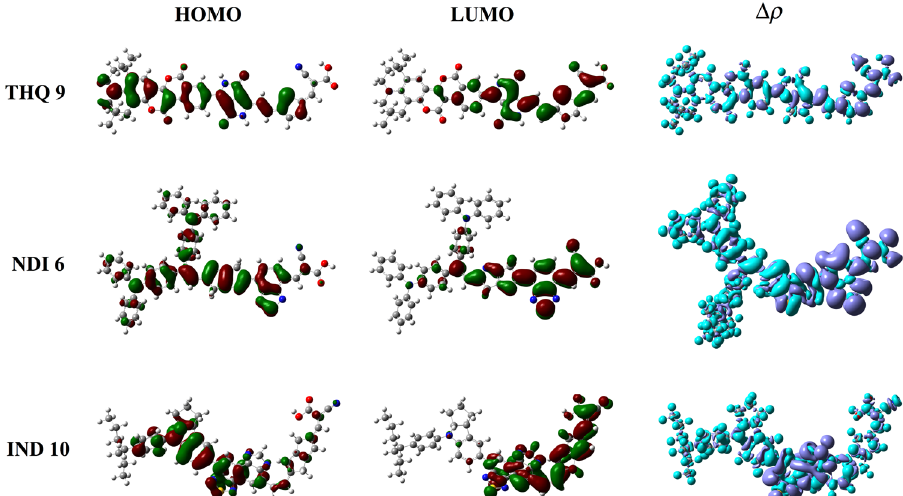
Fig. 3 Contour plots of HOMO and LUMO of the highest %PCE predicted dyes for all three classes at B3LYP/6-31g(d,p) level of theory along withthe charge density difference ( Δ ρ ) between the excited and ground states of the dyes. Purple and cyan colors indicate increase and decrease of the charge density, respectively